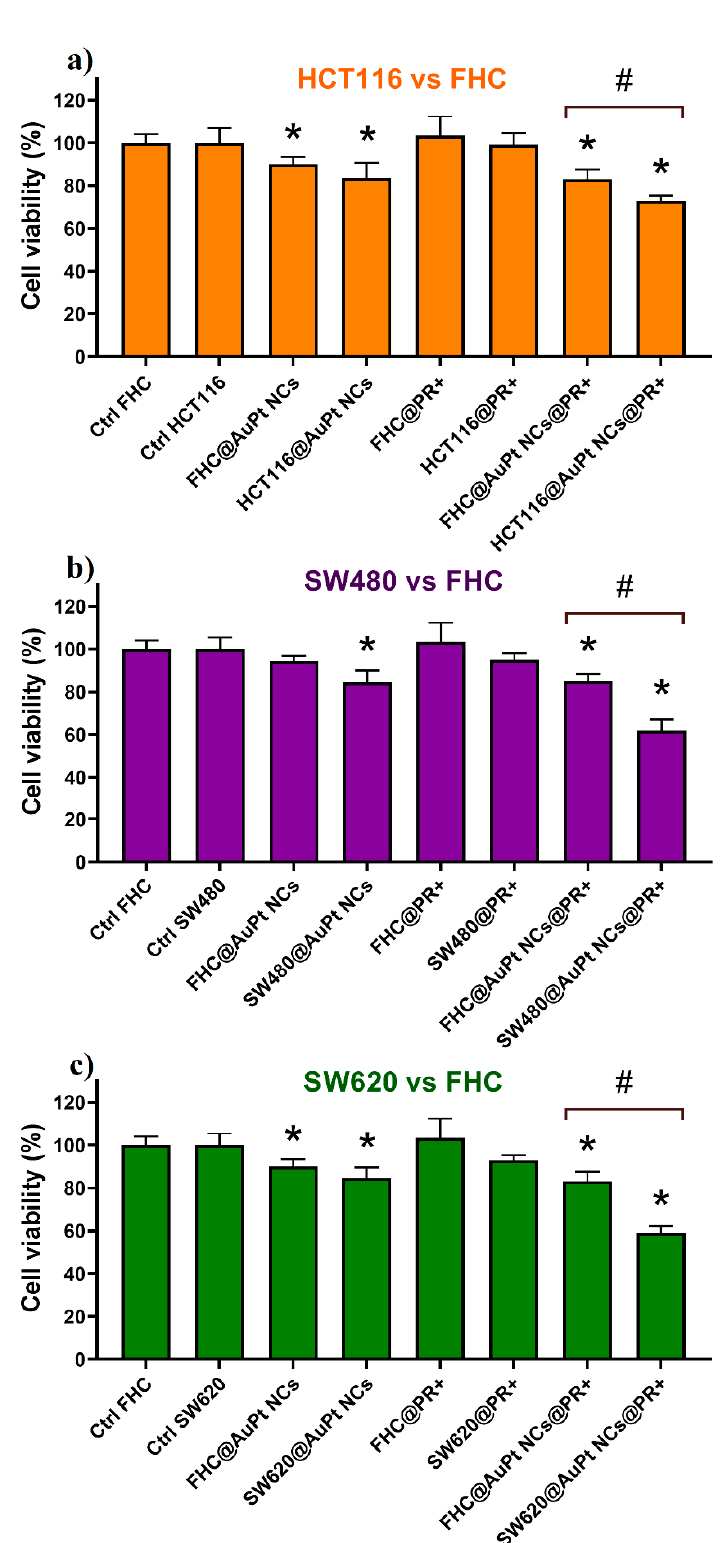
Figure 6. Viability of ( a ) HCT116, ( b ) SW480, and ( c ) SW620 cancer cells compared to FHC normal cells after the addition of AuPt NCs and proton irradiation of a total dose of 15 Gy combined with AuPt NCs: data were considered significant if * p < 0.05 versus control; # p < 0.05—statistically significant differences between the respective cancer line and the normal line.